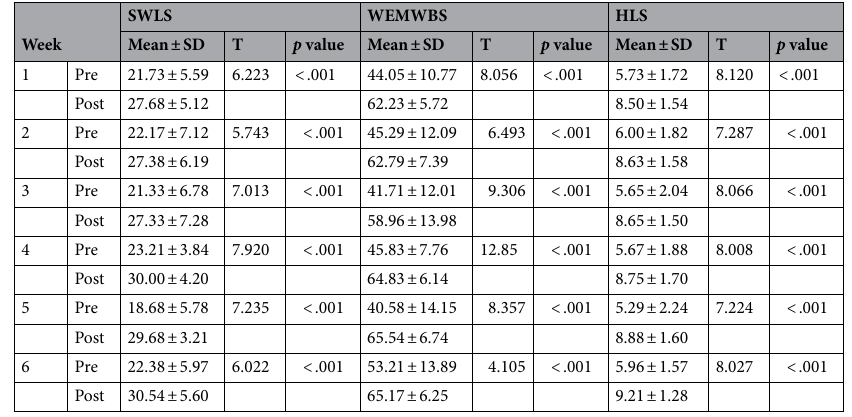
Table 2. The SWLS, WEMWBS and HLS scores preactivity and postactivity in each week. SWLS, Satisfaction with Life Scale; WEMWBS, Warwick–Edinburgh Mental Well-being Scale; HLS, Happiness and Life